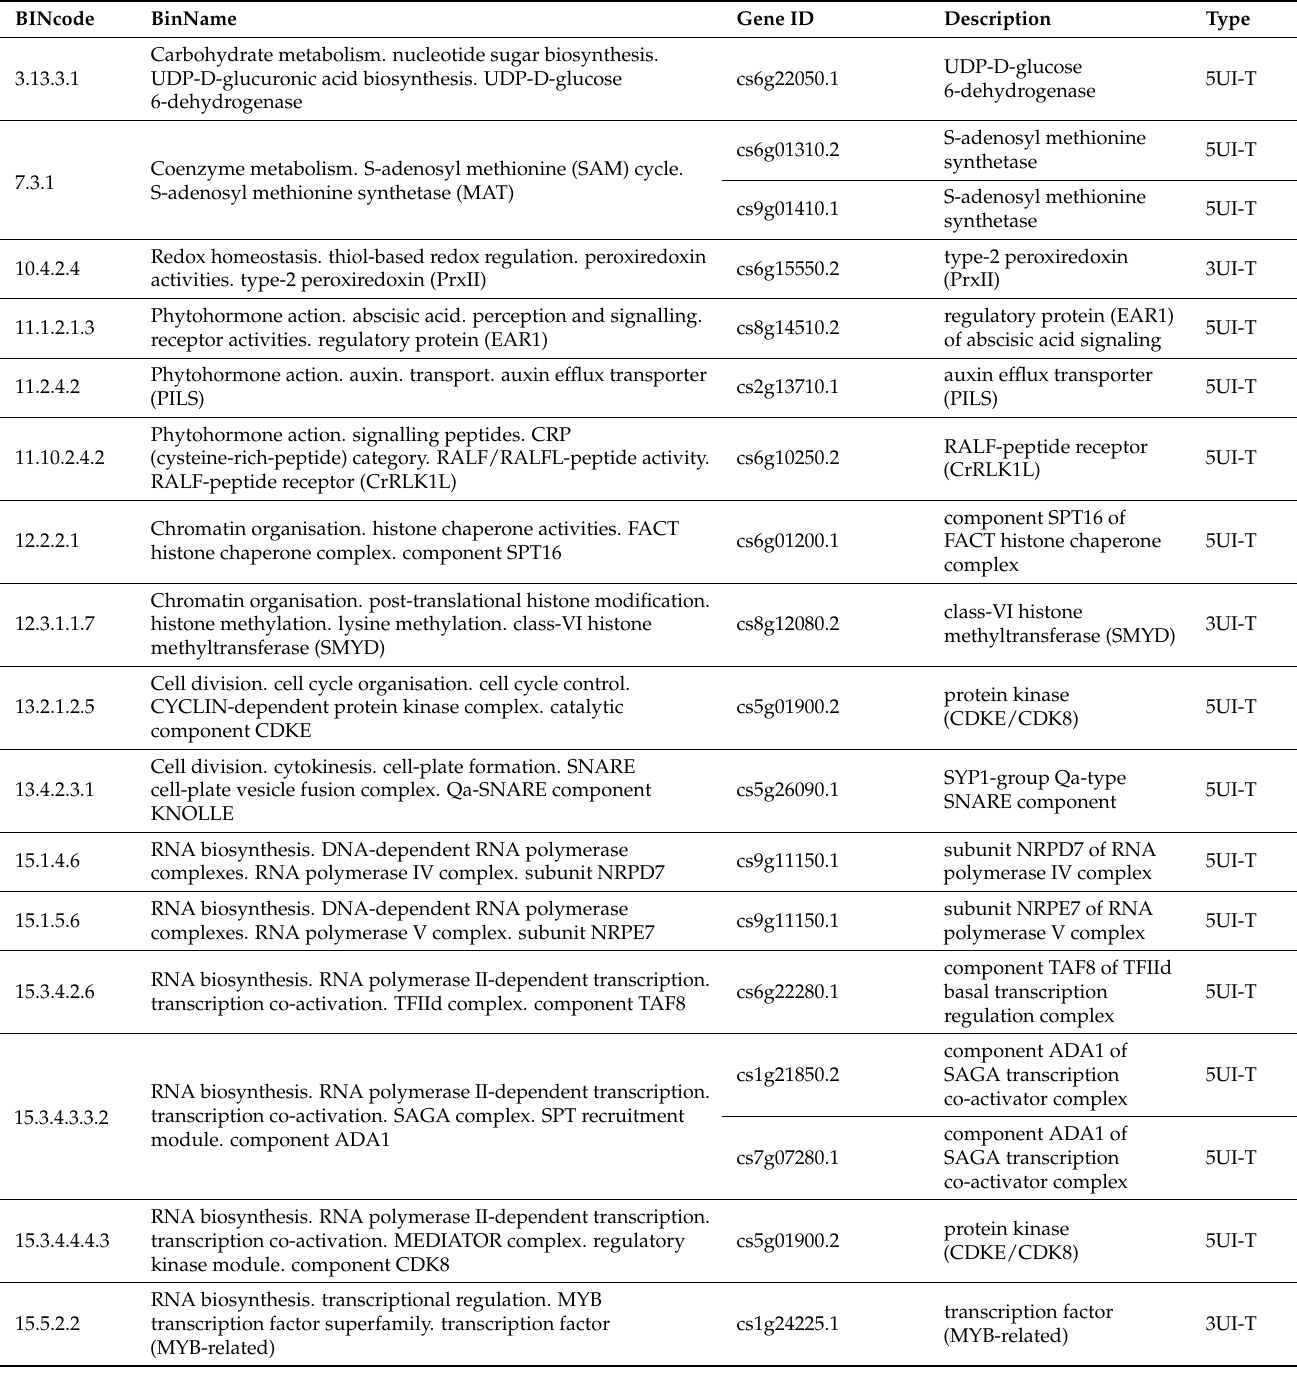
Table 4. Annotation results for the common UI-containing transcripts identified in this study. 5UI-T: transcripts containing common 5UI; 3UI-T: transcripts containing common 3UI; 5&3UI: transcripts containing both common 5UI and 3UI. MapMan annotation was performed using the C. sinensis gene mapping